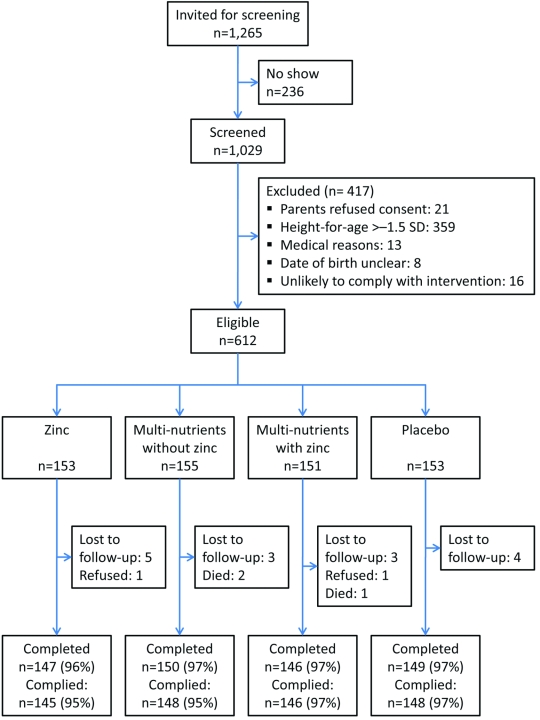
Flow chart of study recruitment and follow-up.Compliance was measured as the proportion of children who consumed >95% of scheduled supplements.